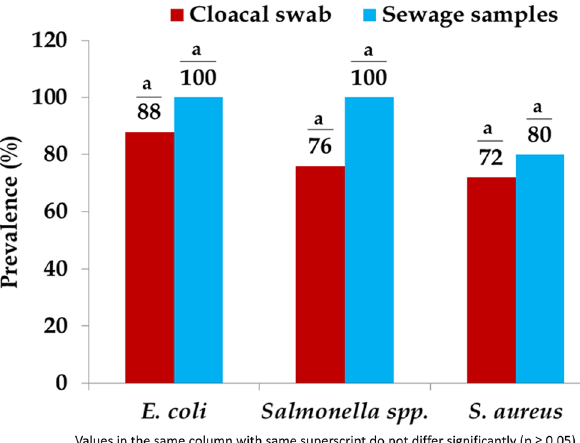
Figure 1. Prevalence of E. coli , Salmonella spp. and S. aureus isolated from cloacal swab and sewage samples following